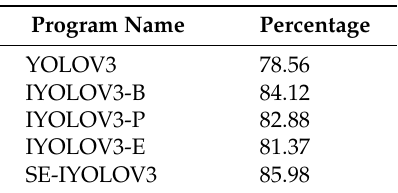
Table 2. Average intersection:parallel ratio of the prediction box and real box. b, anchor box; P, prediction